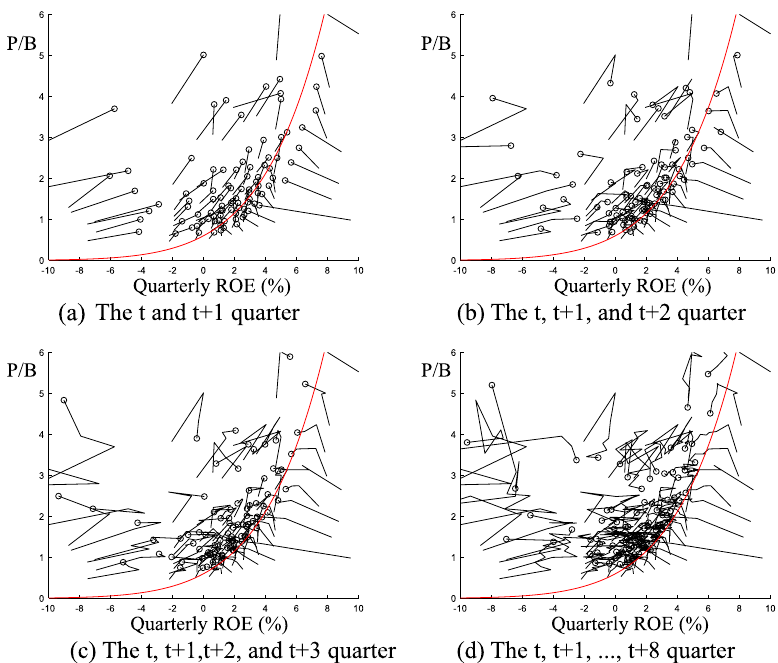
Fig. 21 The movement path of ROE (X axis) and P/B (Y axis) in the current quarter and the subsequent 1, 2, 3, and 8 quarters: Large momentum